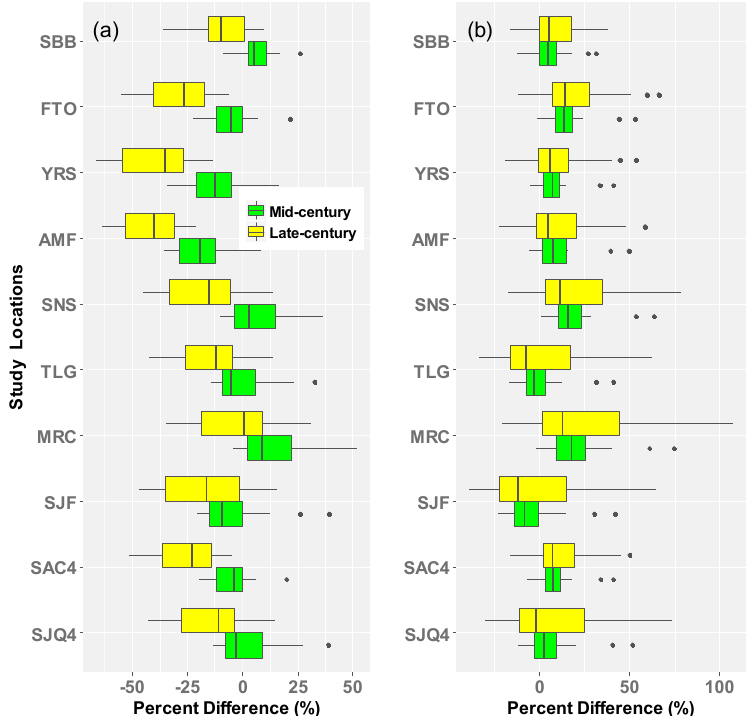
Figure 6. Box-and-whisker plots of percent difference (%) between historical baseline and individual RCP 4.5 and individual RCP 8.5 projections on ( a ) April–July runoff; and ( b ) Annual runoff in mid-century and late-century for all study locations. Each box plot shows information of 20 projections derived from 10 GCMs under two RCPs.